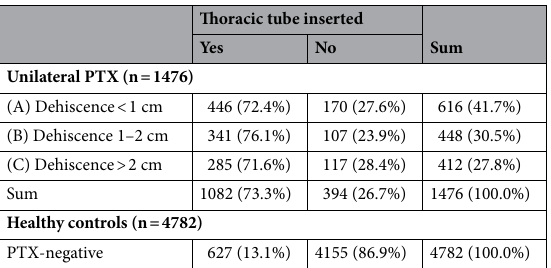
Table 1. Characteristics of the SCXR PTX cohort. The table shows the absolute and relative quantities of the subgroups that are covered in the cohort. The pneumothorax group is furthermore subdivided in terms of the measured maximal pleural